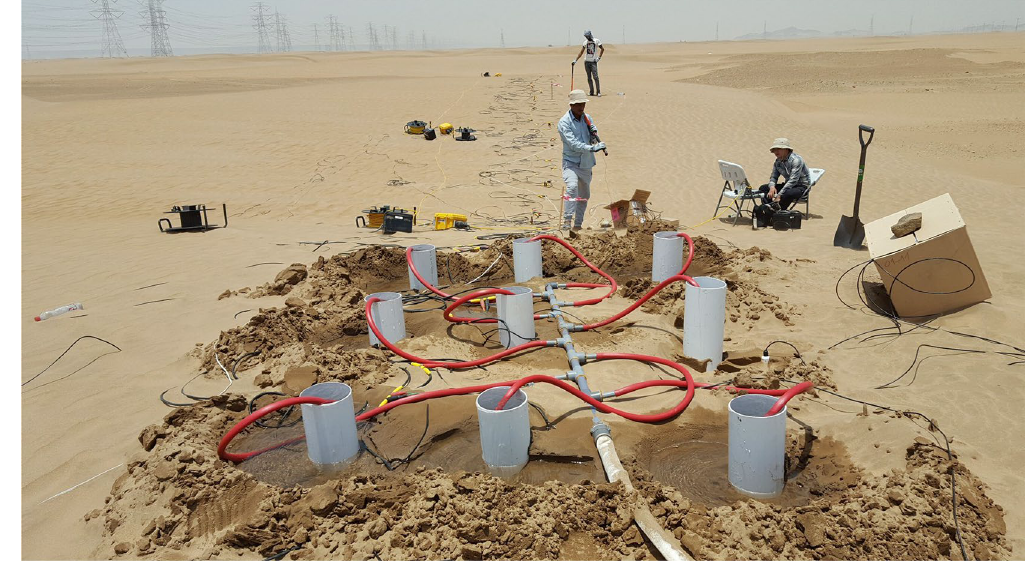
Figure 2. Photograph of the field experiment where the seismic data are recorded over the sand dune during the injection of 12-tons of